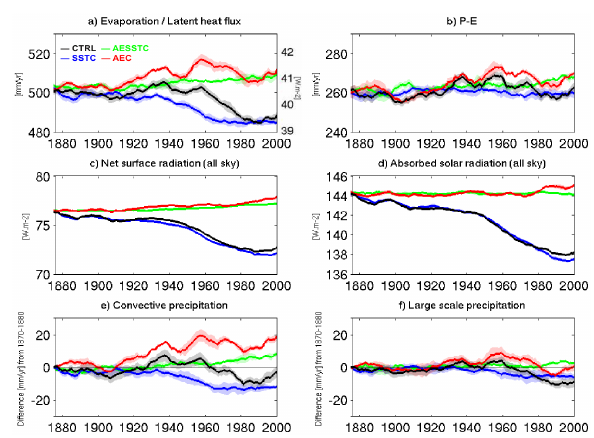
Fig. 8. Simulated annual global land absolute values of evapo- Figure 8. Simulated annual global land absolute values of evaporation (left hand side axis, ration (left hand side axis, mmyr − 1 ) and latent heat flux (right mm/year) and latent heat flux (right hand side axis, W/m2) (a), precipitation minus hand side axis, Wm − 2 ) (a) , precipitation minus evaporation (P-E, evaporation (P-E, mm/year) (b), net surface radiation all sky (W/m2) (c) and absorbed solar mmyr − 1 ) (b) , net surface radiation all sky (Wm − 2 ) (c) and ab- sorbed solar radiation all sky (Wm − 2 ) (d) , as well as anomalies radiation all sky (W/m2) (d), as well as anomalies of convective (e) and large scale precipitation (f) (mm/year; ref: 1870-1880). All the time series are shown as 11-years running of convective (e) and large scale precipitation (f) (mmyr − 1 ; ref: means. Shaded areas correspond to the +/- 1 sigma spread of each ensemble. 1870–1880). All the time series are shown as 11yr running means. Shaded areas correspond to the ± 1 sigma spread of each